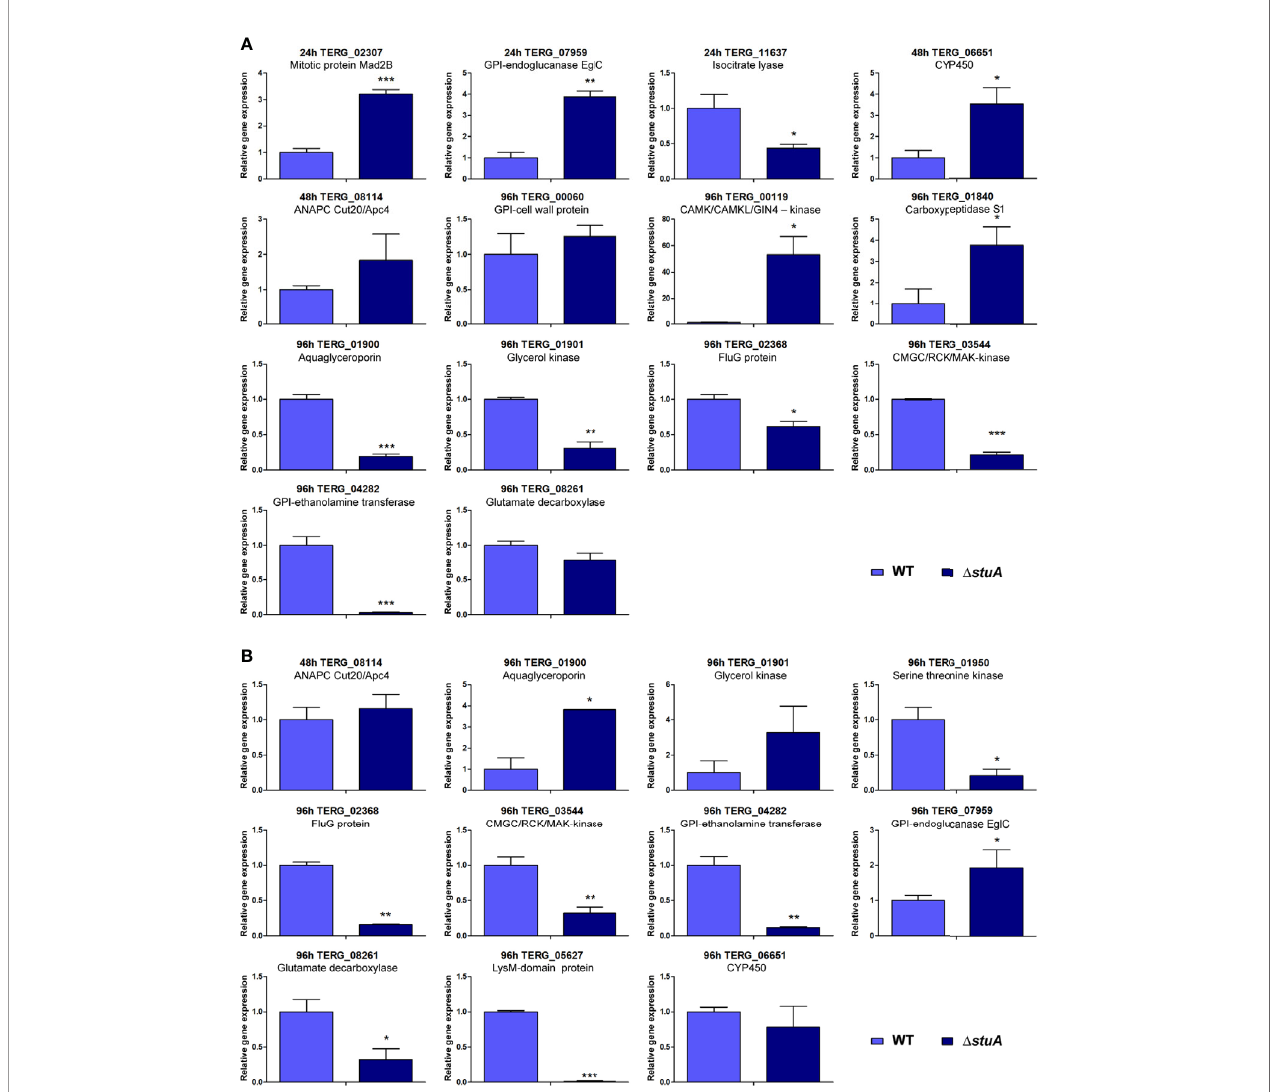
FIGURE 3 | Panel of genes validated by RT-qPCR. Transcript levels are represented as fold-change values at each time point in the D stuA strain during grown in (A) glucose- and (B) keratin-supplemented medium relative to control (wild-type strain). Statistical signi fi cance was determined using an unpaired t -test (* P < 0.05; ** P < 0.01; *** P <